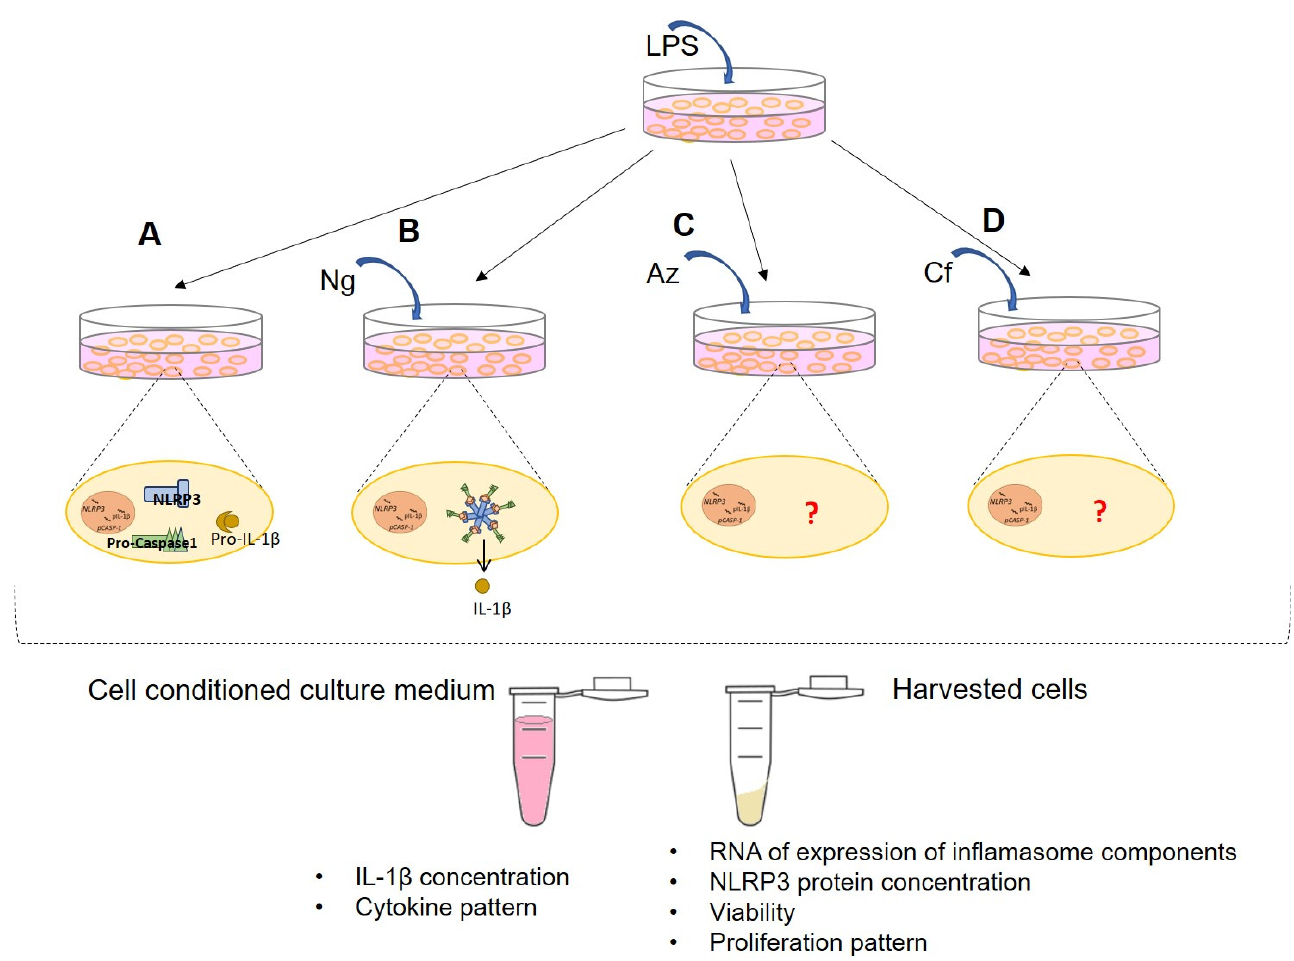
Figure 1. Experimental design of treatment schedules for A549 and PC3 cells. ( A ). LPS-only treat- ment for 3 h to prime NLRP3. ( B ). LPS-Ng treatment for 24 h are used as a positive control to activate the NLRP3 inflammasome complex. ( C , D ). The experimental test groups are treated with ( C ) Az or ( D ) Cf for 24 h after pretreatment with LPS for 3 h.